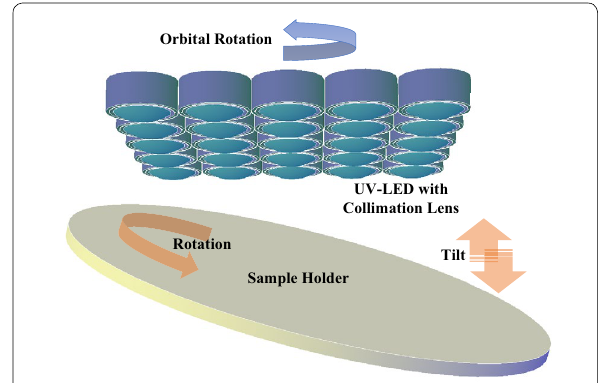
Fig. 1 Description of multidirectional UV-LED